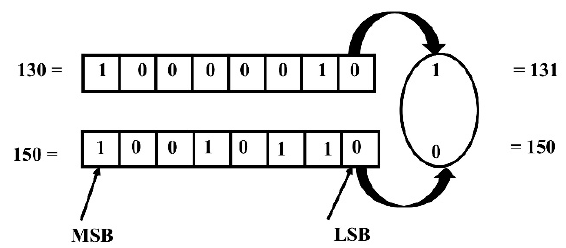
Figure 8. Basic least significant bit (LSB) technique example.